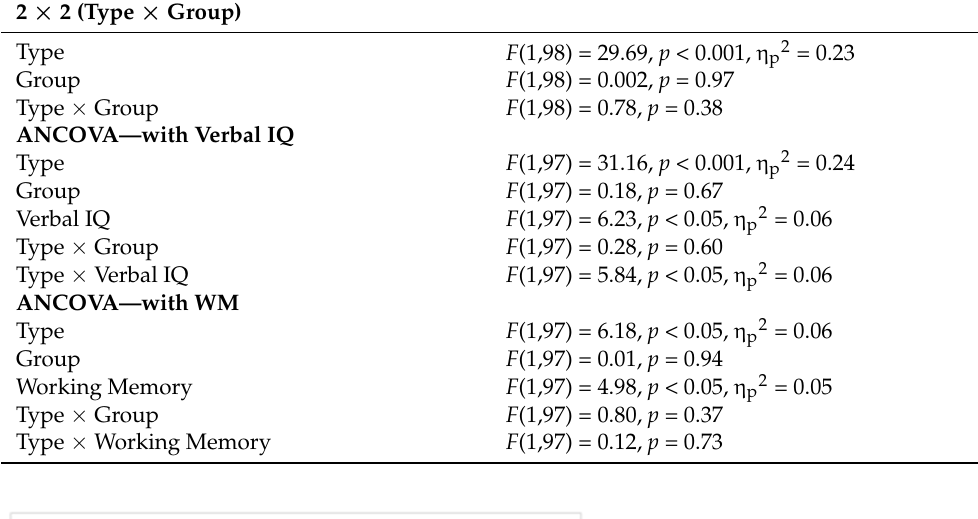
Table 4. Inferential results for comprehension accuracy.